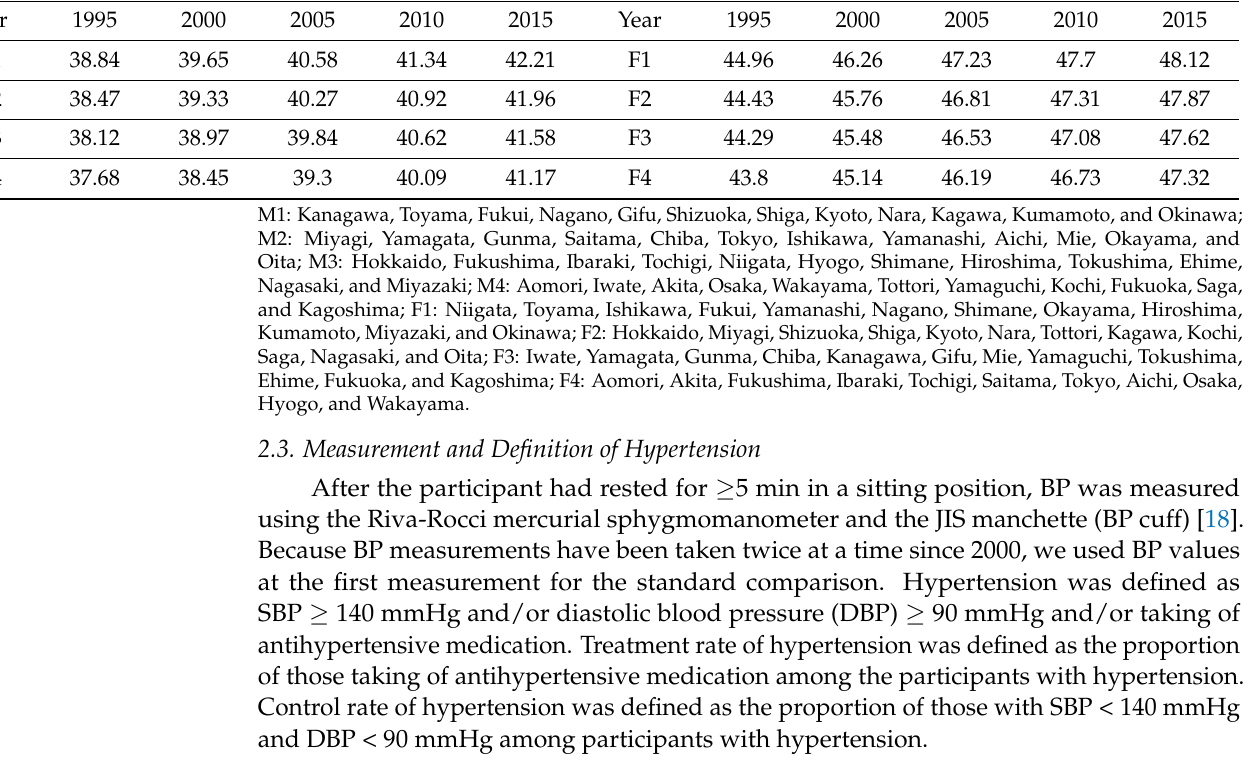
Table 1. Mean life expectancy at the age of 40 years for four groups according to life expectancy by sex in each prefecture in 2000. Men